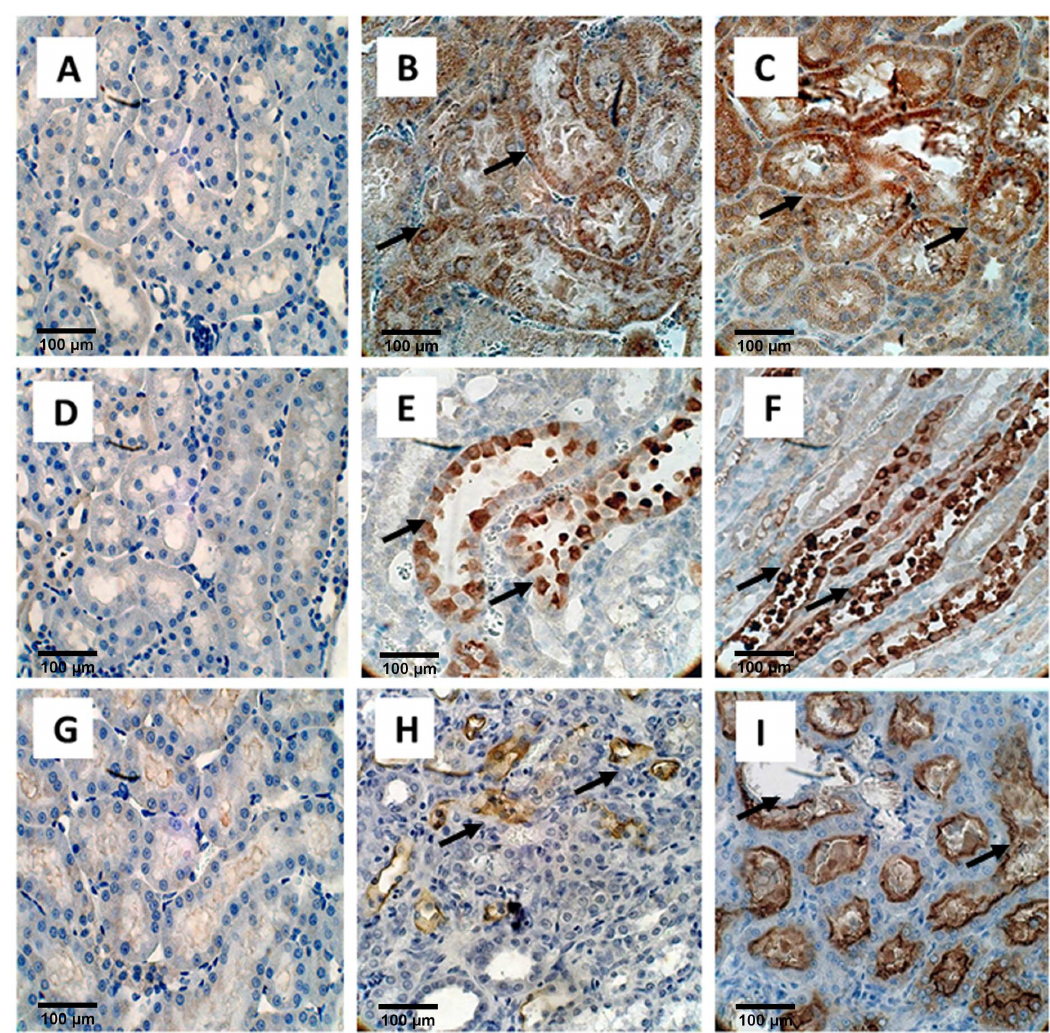
Fig 6. Immuno-histological staining of EG treated rat kidneys. NOX2, A) Control B) Day 14 C) Day 28. Stainingis similar on both days and seen in both the renal tubular epithelialcells as well as interstitium shown by black arrows. NADPH oxidase4 or NOX4, D) Control E) Day 14 and F) Day 28. Stainingappearssimilar on both days and limited to the renal epithelialcells of the ascendinglimbs of the Loop of Henle(black arrows showingstaining of renal epithelialcells). KIM1, G) Control H) Day 14 showinglight localizedstaining (black arrows) and I) Day 28, showinglarge distendedtubule from which crystals have fallen duringprocessing(Black arrow) and there is heavy expressionboth in the tubular cells